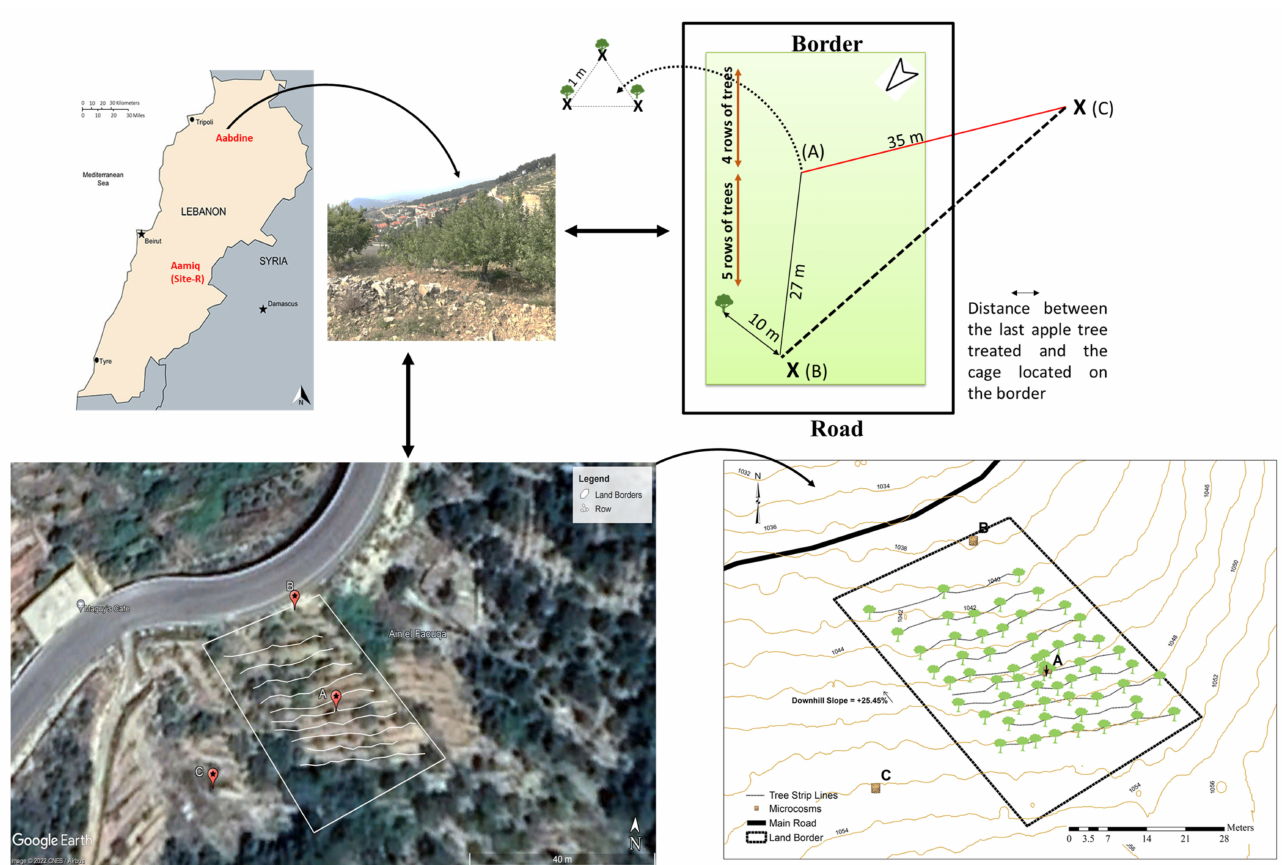
Figure 1. Study site showing the location of the three locations, A, B, and C, of the orchard. X indicates the location of the microcosms; the three microcosms installed at Site-A were 1 m distant from each other and were installed directly under the trees, as